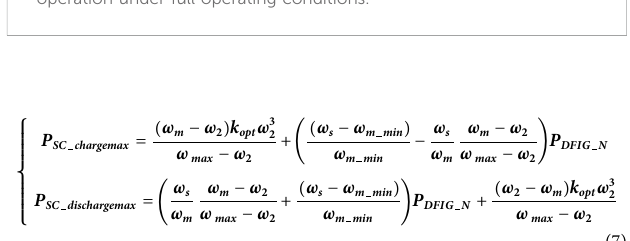
FIGURE 3 Comparison of DFIG and Energy storage type DFIG power operation under full operating